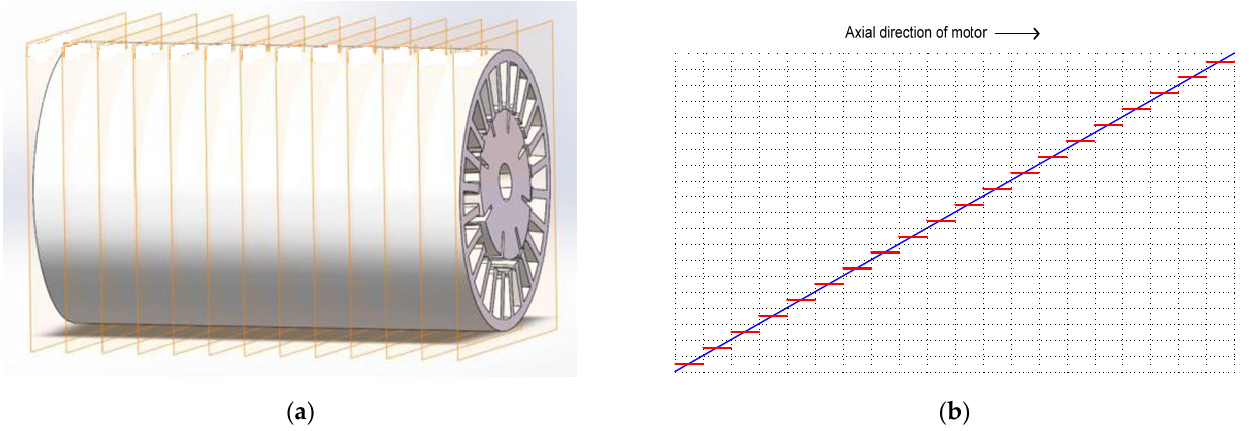
Figure 2. Ideology of equivalent algorithm: ( a ) a skewed electromotor is divided into several sections; ( b ) the whole winding conductor in the segmented skewed slot is replaced by several straight conductors.